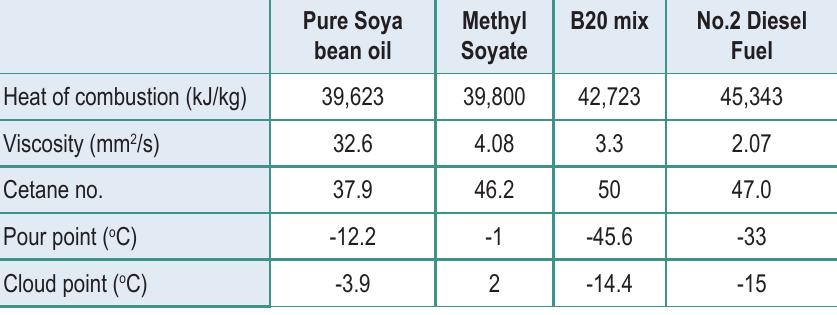
Table 1. Properties of selected diesel fuels